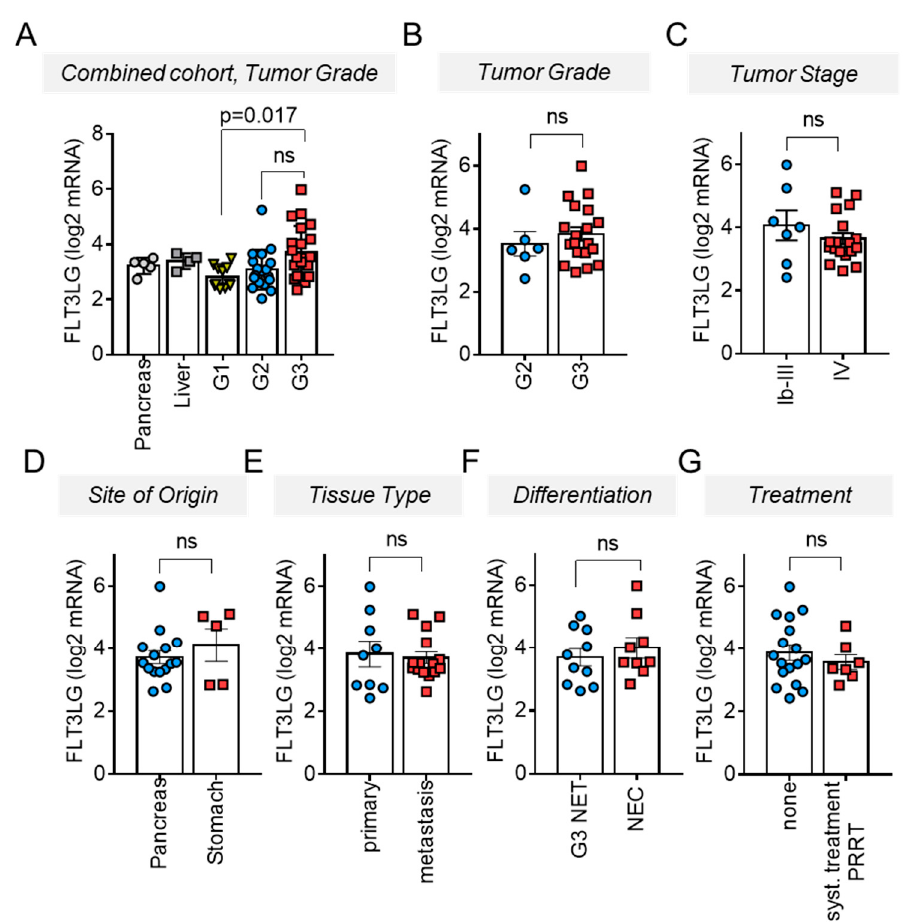
Figure 1. Increased FLT3LG mRNA expression in G3 NEN. FLT3LG mRNA expression data as determined based on the log2 transformed normalized TPM values from the transcriptome data of the combined cohort. Bars and error bars indicate Mean ± SEM. ( A ) Comparison between tumors of different grades revealed increased expression in G3 NEN ( n = 21) when compared to G1 tumors ( n = 14) (Kruskall–Wallis test). FLT3LG mRNA expression in non-transformed pancreas ( n = 5) and tumor free liver tissue ( n = 4) is shown for comparison. ( B – E ) Correlation of FLT3LG mRNA expression with clinicopathological parameters in the advanced tumors of the Charit é subcohort. Grades 2 versus 3 ( B ), stage IV ( C ), different tissue origin ( D ), tissue type ( E ), morphologic tumor differentiation ( F ) or prior systemic treatments except SSA (chemotherapy, targeted therapies, PRRT) ( G ) were not reflected by differences in FLT3LG mRNA. Kruskall–Wallis ( A ) and Mann–Whitney test ( C – G ) were used for determination of p -values; p > 0.05 was considered not significant